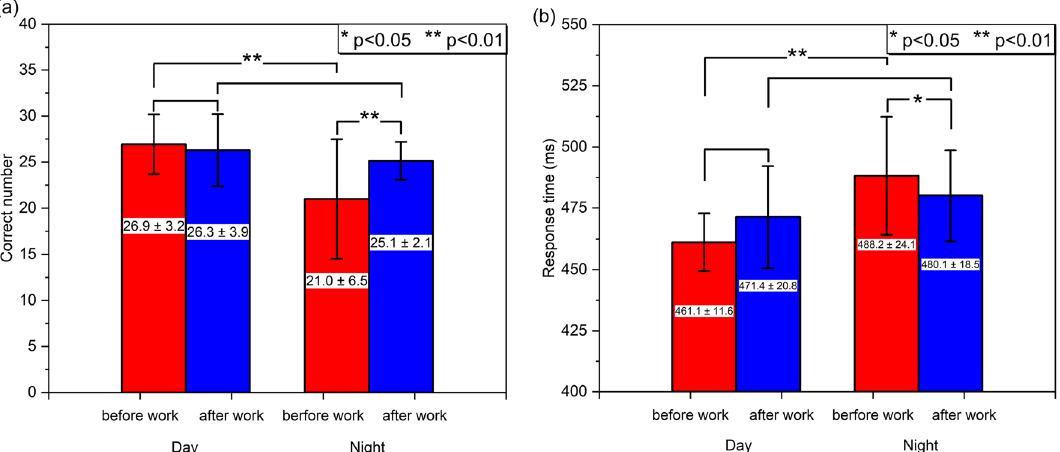
Figure 2. ( a ) The number of correct responses and ( b ) response time of CPT after and before working segment during the daytime and at night. The red and blue columns represent the CPT results before and after work, respectively. The mean ± SD is marked on the columns and the error bars represent the SD. (The figure was generated by Origin 2018, URL: https:// www. origi nlab. com/).